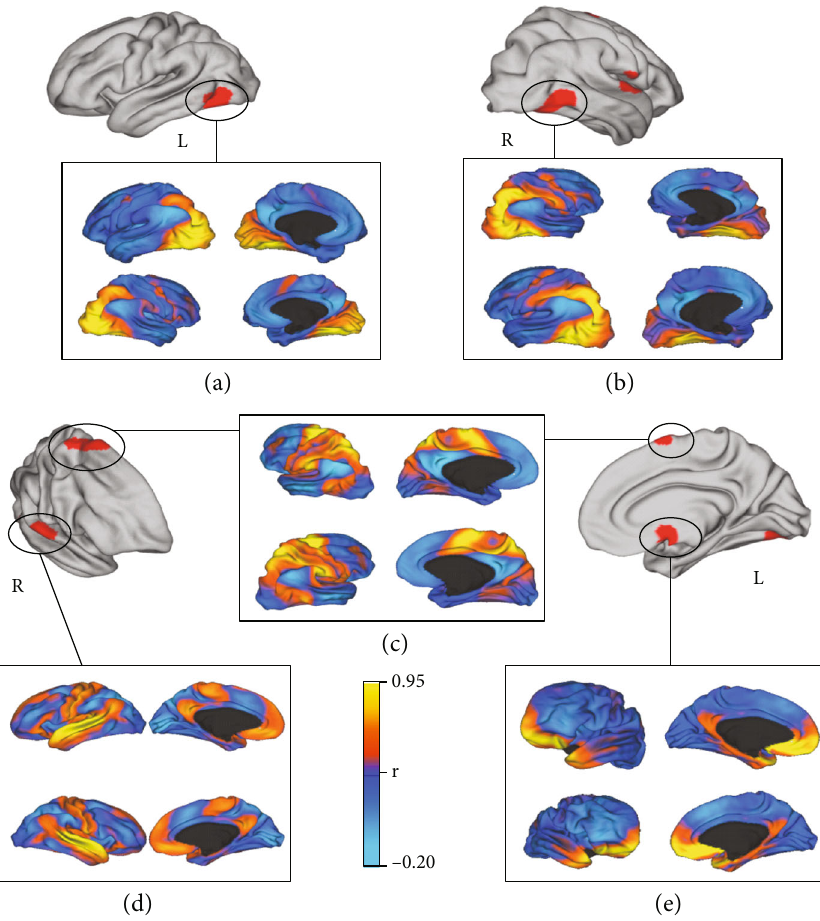
Figure 7: Network mapping of o ff -targets results. The fi gure shows the functional connectivity of the bilateral occipital cortices (a, b), corresponding to the right and left fusiform gyrus (MNI coordinates ( x , y , z ): -36, -70, and -18; 56, -58, and -14), of the supplementary motor area (c) (MNI coordinates ( x , y , z ): 14, 6, and 64); of the superior temporal gyrus (d) (MNI coordinates ( x , y , z ): 66, -8, and 4) and of the subgenual cortex (e) (MNI coordinates ( x , y , z ): 4, 4, and -24). R: right; L: